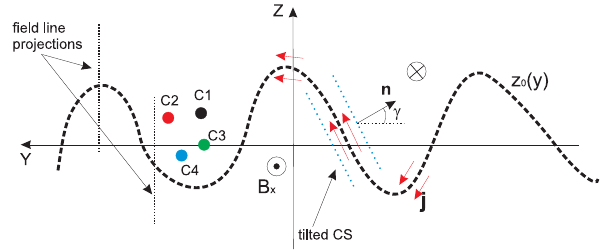
Fig. 1. The model of the wavy CS: thick dashed curve z = z 0 (y) is the bent neutral plane; black dashed vertical lines show projections of the magnetic field lines onto the YZ plane; circles show the di- rection of B x ; red arrows show the current density j ; colored points C1–C4 present Cluster; blue dashed lines show a tilted CS; n is the CS normal vector; the angle γ determines the CS